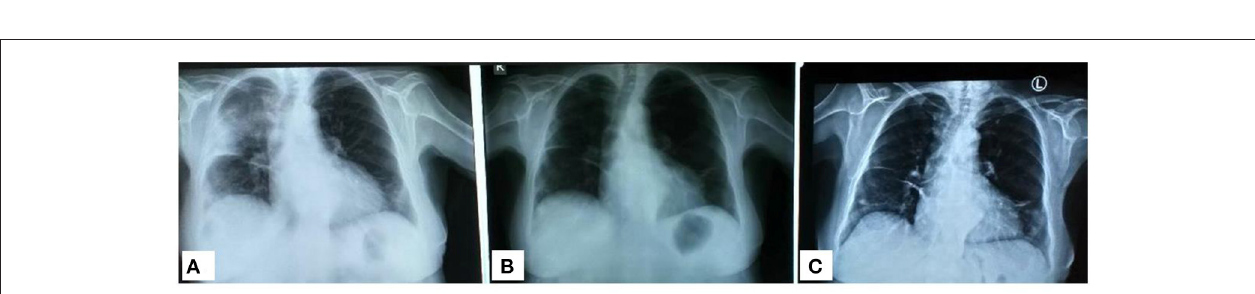
FIGURE 1 | Serial thoracic computed tomographies (CTs) that demonstrate the lesion migration. (A) Image before corticosteroid initiation. (B) Image after the initial short-term corticosteroid treatment. (C) Image at the time of the CT-guided biopsy. (D) Fine-needle biopsy (FNB) cutoff point.